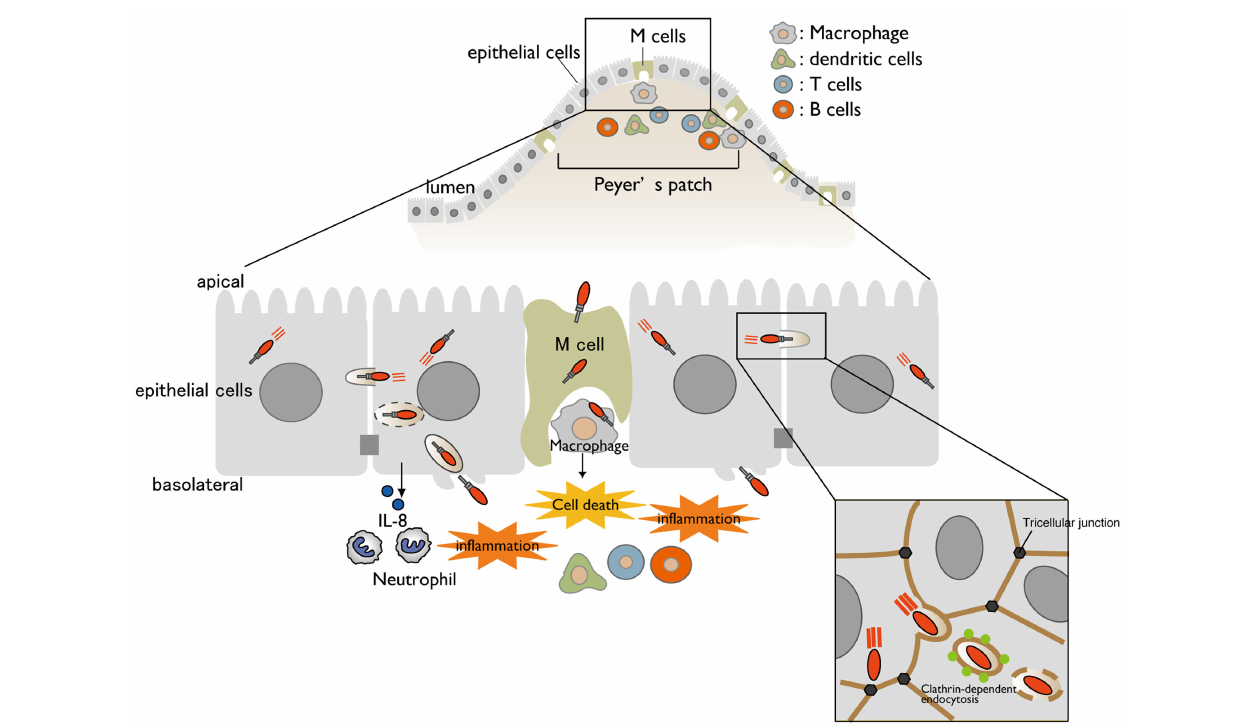
FIGURE 1 | A model for Shigella infection of the intestinal epithelium . A schematic representation of Shigella infection. Bacterial invasion and multiplication within macrophages and epithelial cells cause subsequent massive inflammatory colitis, termed as shigellosis. Cell-to-cell movement of Shigella occurs at tricellular junctions via clathrin-dependent